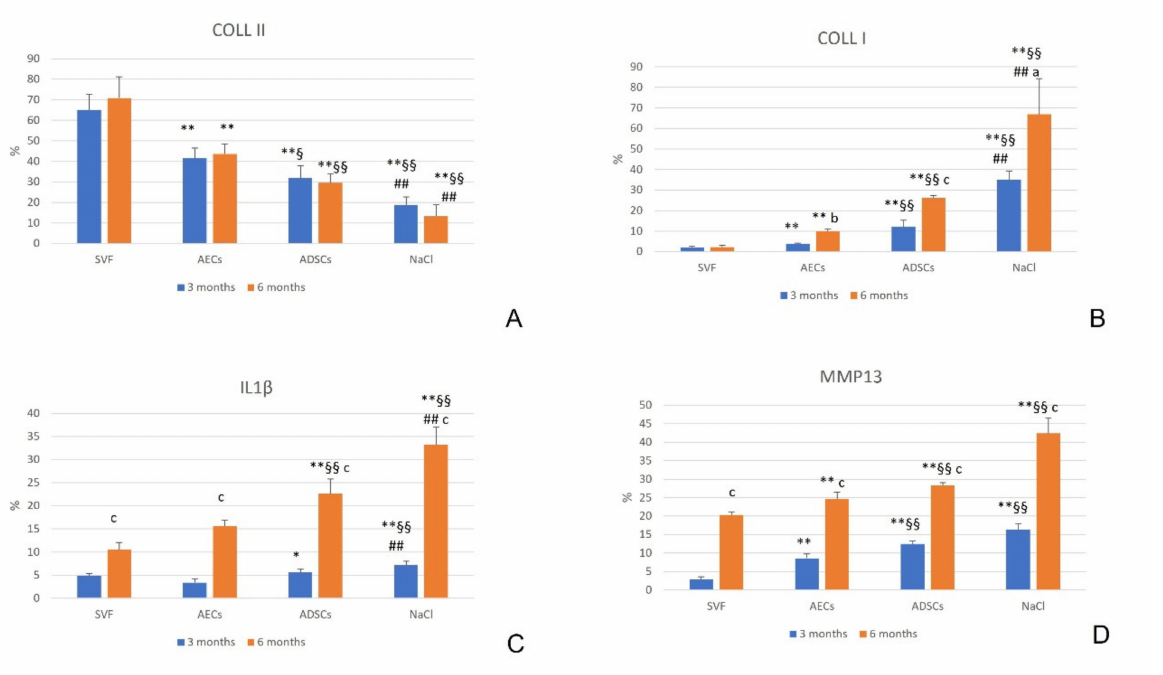
Figure 5. Mean and standard deviation (SD) of immunostaining quantification (%) of Collagen II (COLL II) ( A ), Collagen I (COLL I) ( B ), Interleukin 1 β (IL1 β ) ( C ), and Metalloproteinase 13 (MMP13) ( D ), for all treatment groups: SVF, AECs, ADSCs and NaCl, at 3 and 6 months. N = 6. *, p < 0.05; **, p < 0.005: SVF vs. AECs, ADSCs and NaCl. §, p < 0.05; §§, p < 0.005: AECs vs. ADSCs and NaCl. ##, p < 0.005: ADSCs vs. NaCl. a, p < 0.05; b, p < 0.005; c, p < 0.0005: 6 months vs. 3